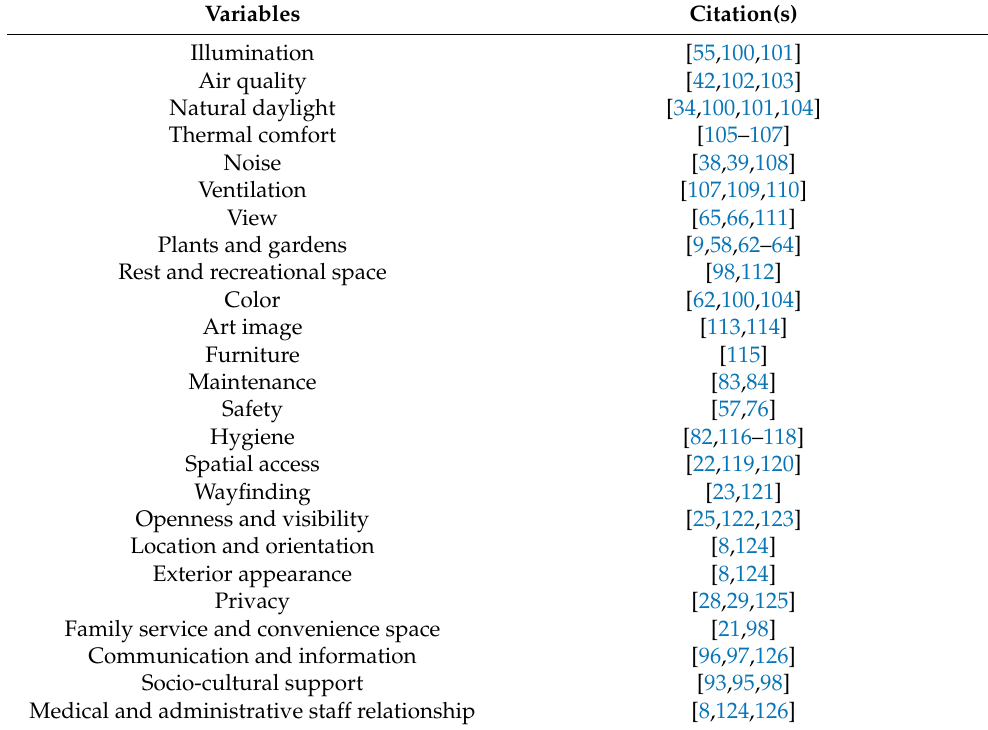
Table 1. Therapeutic healthcare environmental variables and relevant literature